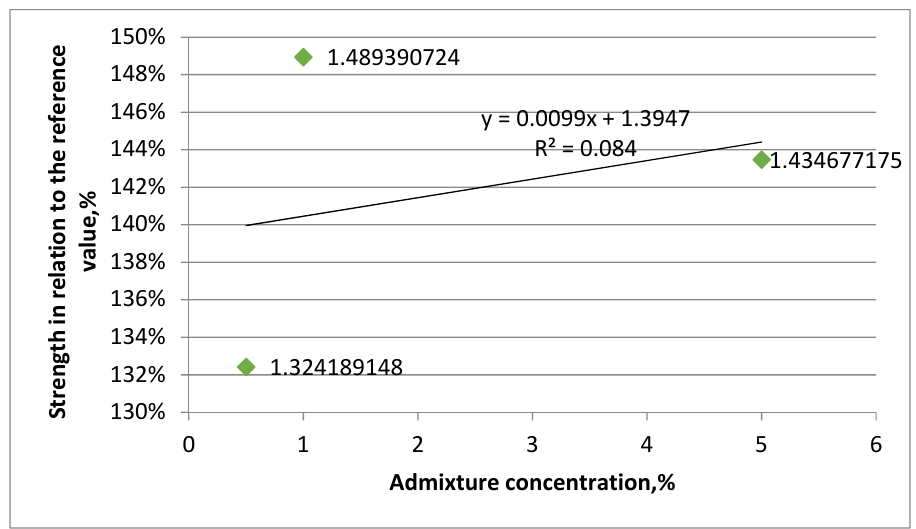
Figure 9. Compressive strength change depending on the type and amount of nanosilica additive— correlation analysis for cement slurry with nanosilica type 3.